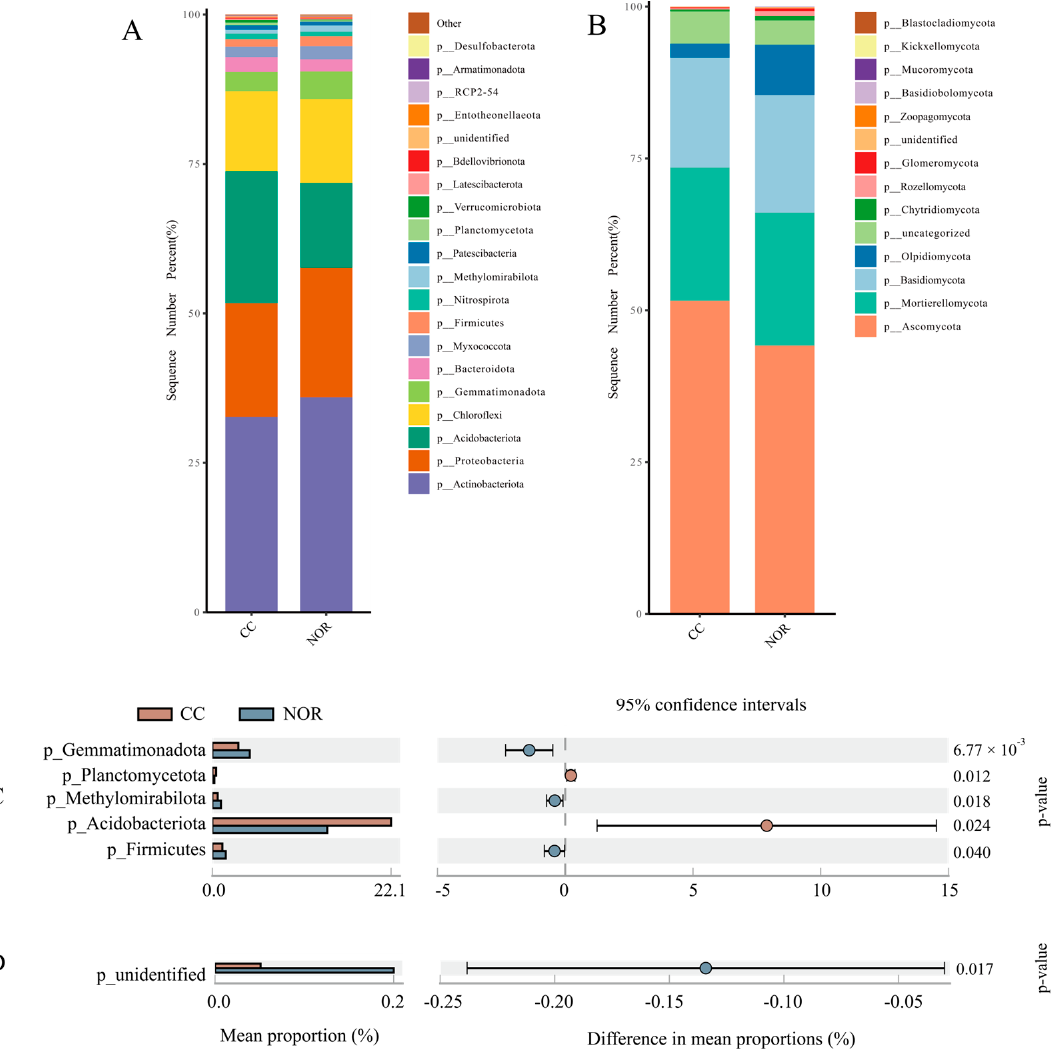
Figure 2. Diversity of rhizosphere microbial community. ( A ): Bacterial phylum level community structure; ( B ): fungal phylum level community structure; ( C ): significantly different bacterial phy- lum ( t -test, p < 0.05); ( D ): significantly different fungal phylum ( t -test, p < 0.05). Error bars are stand- ard errors.